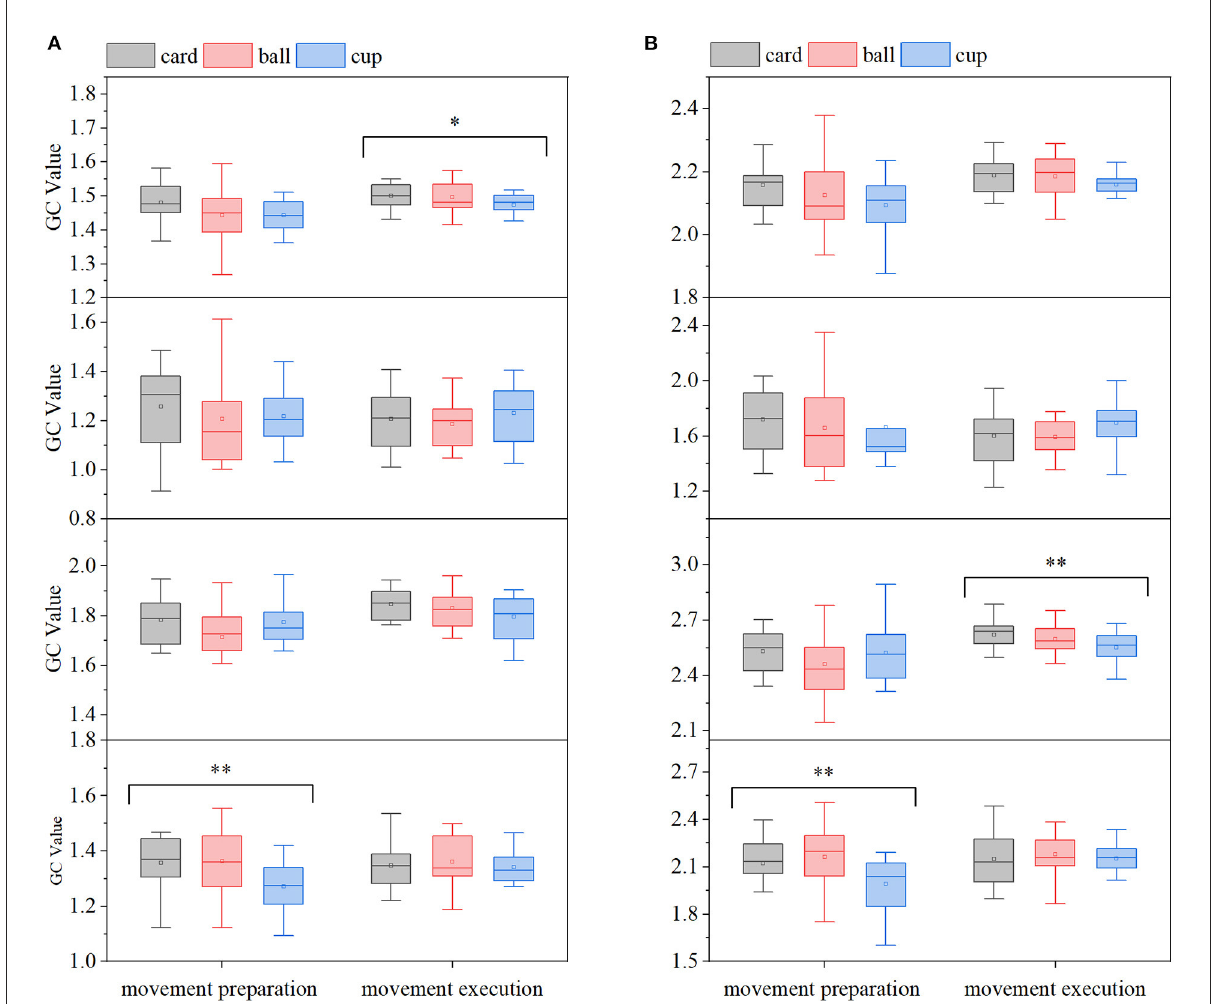
FIGURE7 Comparison of GC averages under different hand-grasping movements (from top to bottom, full frequency, alpha, beta, gamma band, * p < 0.1; ** p < 0.05). (A) EMG → EEG, (B) EEG →